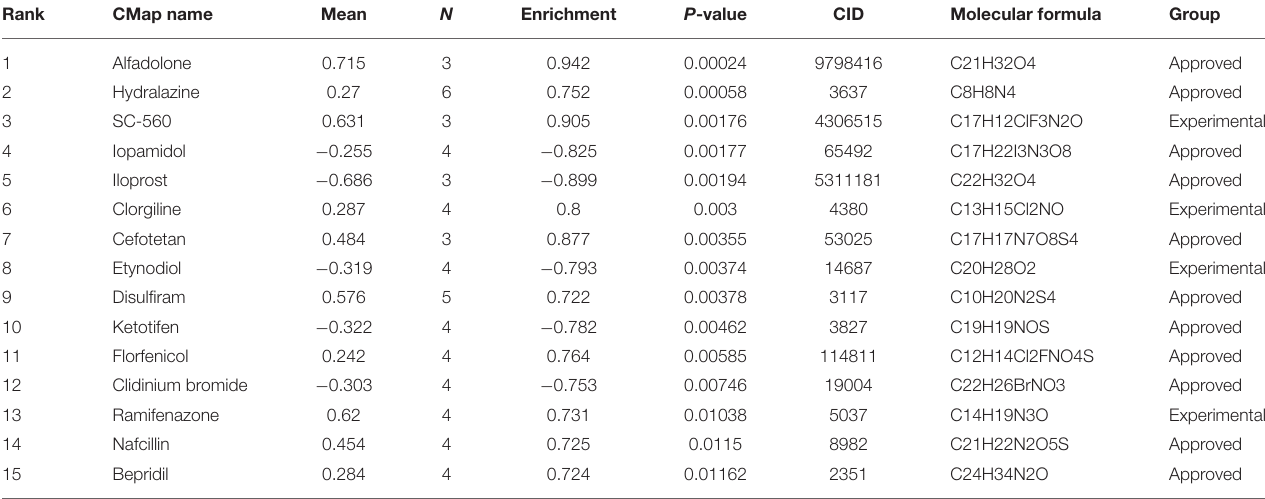
TABLE 2 | Results of CMap analysis of co-DEGs in